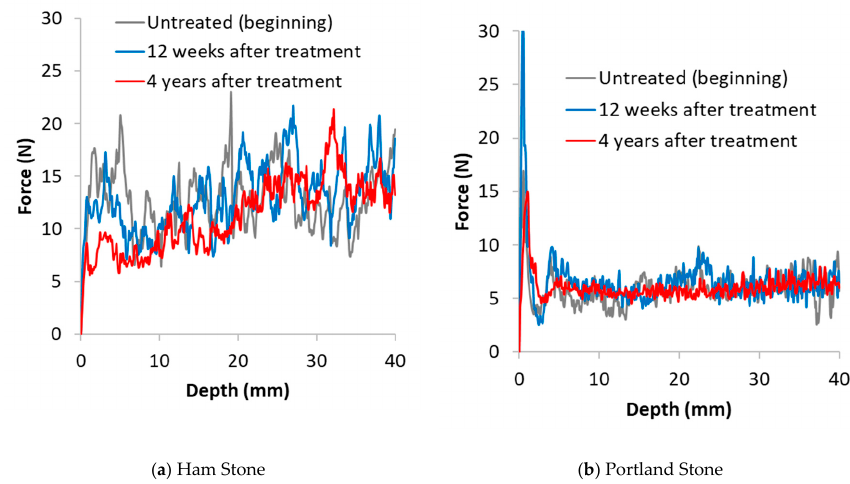
Figure 5. Drilling resistance vs. drilling depth for ( a ) the Ham stone and ( b ) Portland stone, untreated (beginning), 12 weeks and 4 years after treatment.